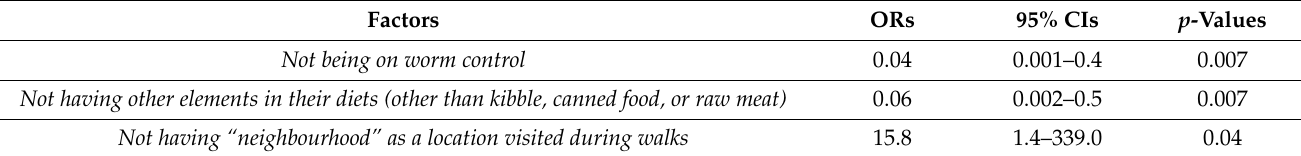
Table 5. Adjusted odds ratios (ORs) and their 95% confidence intervals (95% CIs) for the identified factors in the multivariable model, linked to the presence or absence of colony-forming units (CFUs) of the Enterobacteriaceae family, recovered from dog